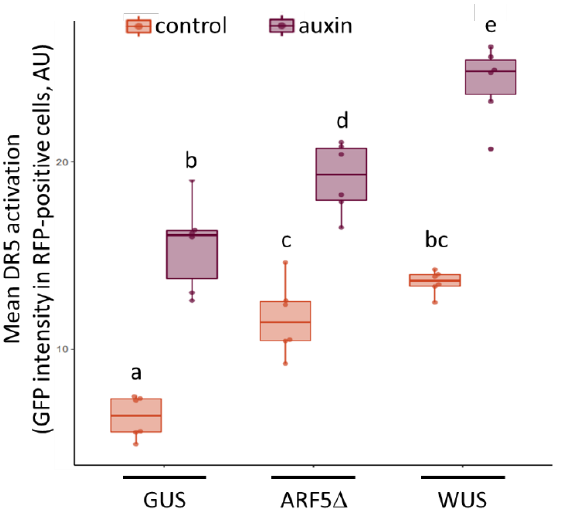
Figure 2. DR5:GFP activation in protoplasts transiently transformed with WUS or ARF5 ∆ . Protoplasts derived from the roots of one-week-old DR5:GFP seedlings were transformed with pBeaconRFP vectors containing a GUS control, ARF5 ∆ , or WUS . Protoplasts were treated with 50 nM IAA, or mock treated, for 24 h and GFP intensity (arbitrary units) in the RFP-positive cells was quantified by flow cytometry. Treatments were performed in triplicate on two independent transformations; statistical significance was assayed by two-way ANOVA followed by a Tukey post hoc test; letters indicate homogeneous subsets ( p < 0.05), n = 6.